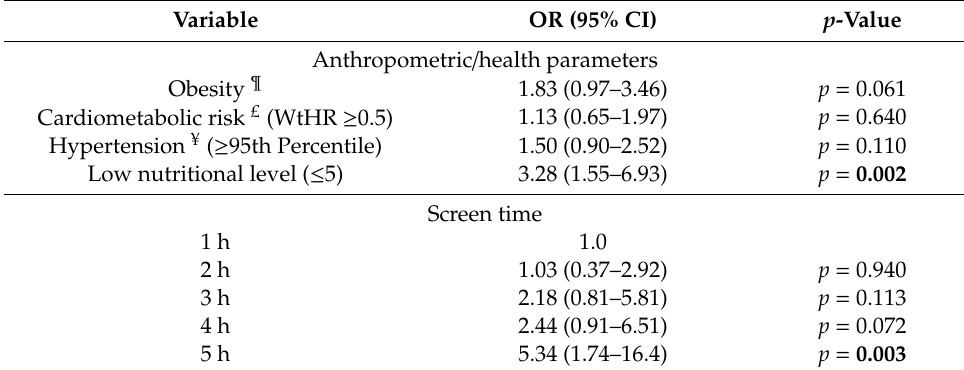
Table 5. Risk to obesity, hypertension, bad lifestyle and low nutritional level in ethnic ascendant